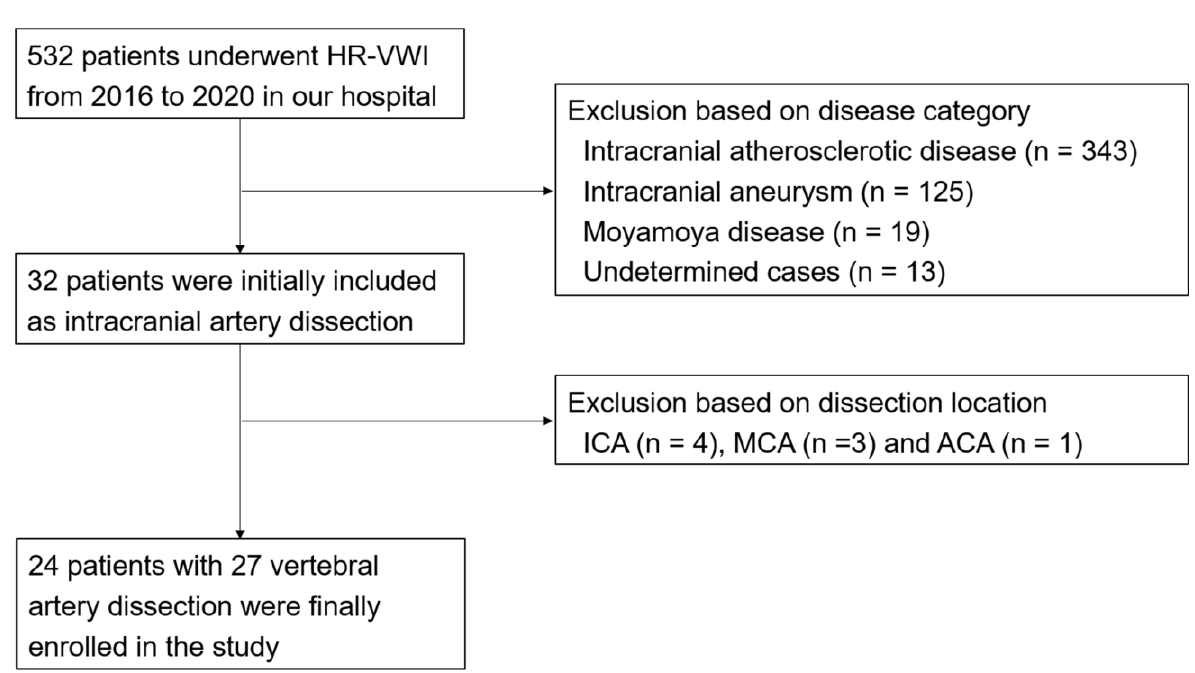
Figure 2. Flow diagram of the patient cohorts for assessment of intracranial vertebral artery dissection. Abbreviations: HR-VWI, high-resolution vessel wall imaging; ICA, internal carotid artery; MCA, middle cerebral artery; ACA, anterior cerebral